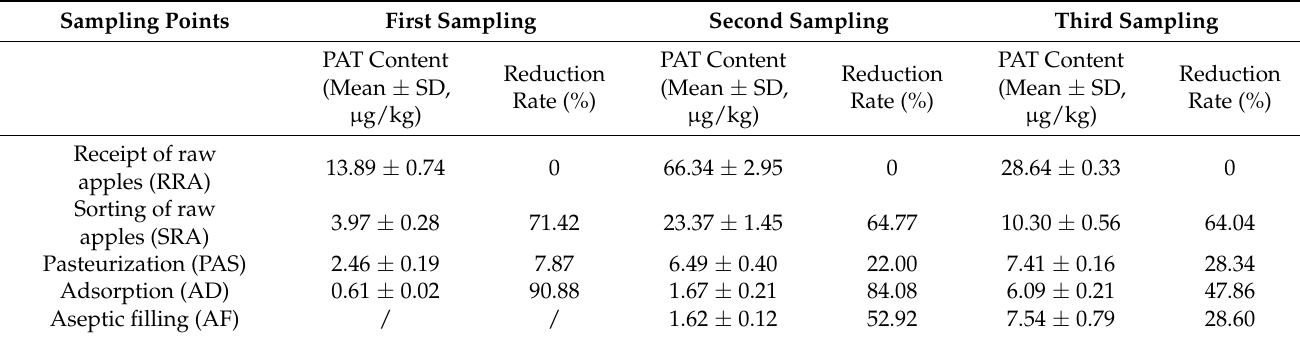
Table 1. Effect of processing stages on PAT content in apple